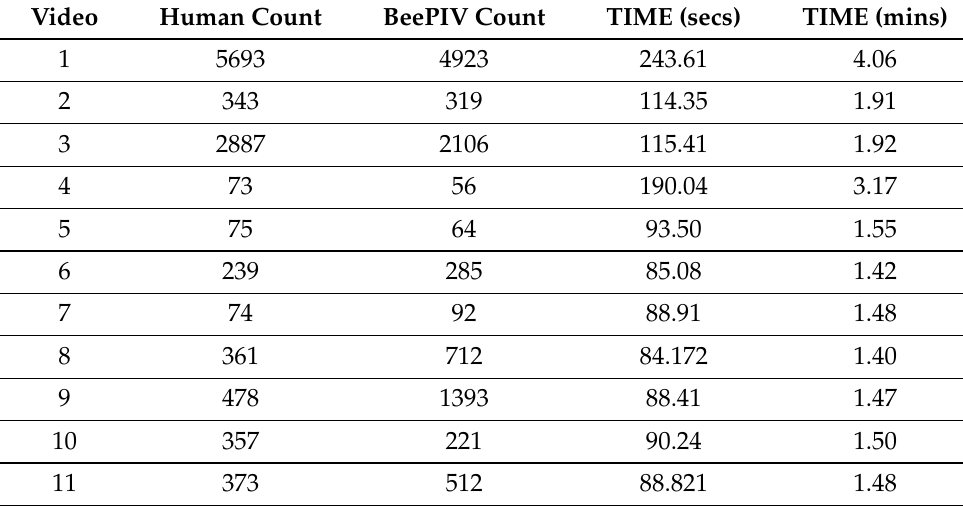
Table 5. Physical processing times for each video in our testbed and evaluation datasets; counts in columns Human Count and BeePIV Count are